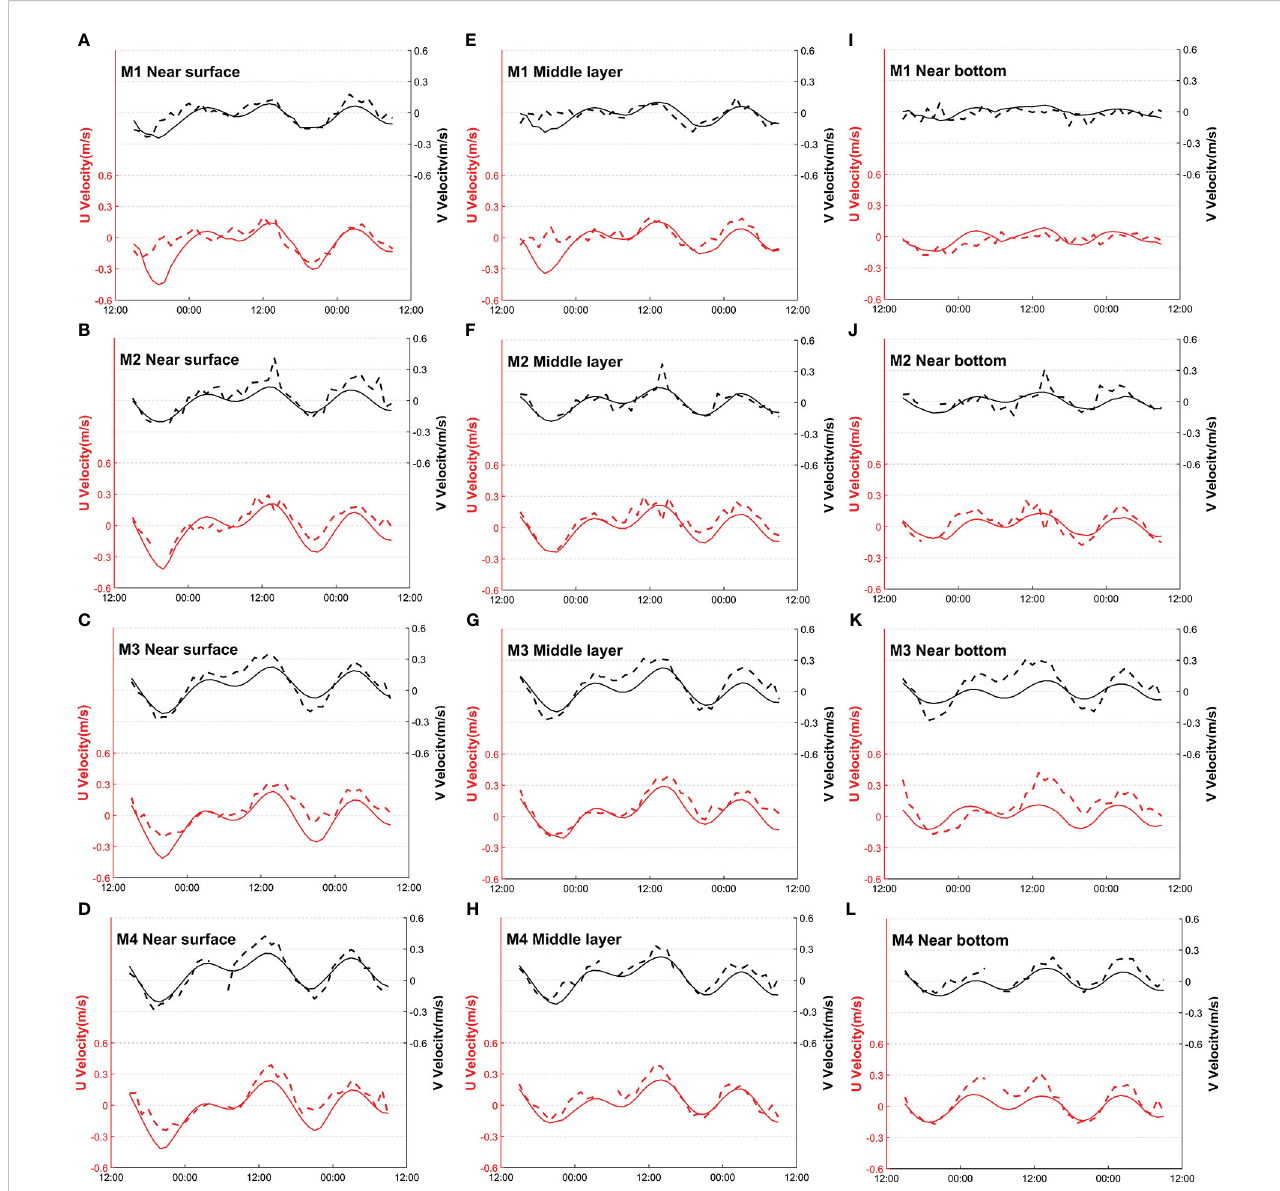
FIGURE 2 (A – L) Current validation between observational data and model outputs at the near surface, middle layer, and near bottom of M1, M2, M3, and M4 stations operating from 2 to 4 November 2021. The black lines at the top indicate northward current velocity (V) at different times (right-hand axis), whereas the red lines below indicate eastward current (U) velocity (left-hand axis). Dashed lines are observational data, and solid lines are model